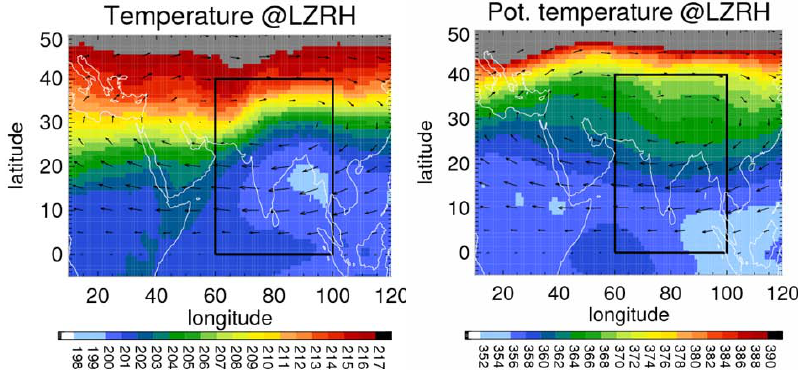
Fig. 2. The clear sky level of zero radiative heating from ECMWF ERA-Interim radiative transfer calculations. Color-coded is the tempera- ture (left) and potential temperature (right) in Kelvin, with arrows showing the wind on this level. Data shown is the June–September average of the year